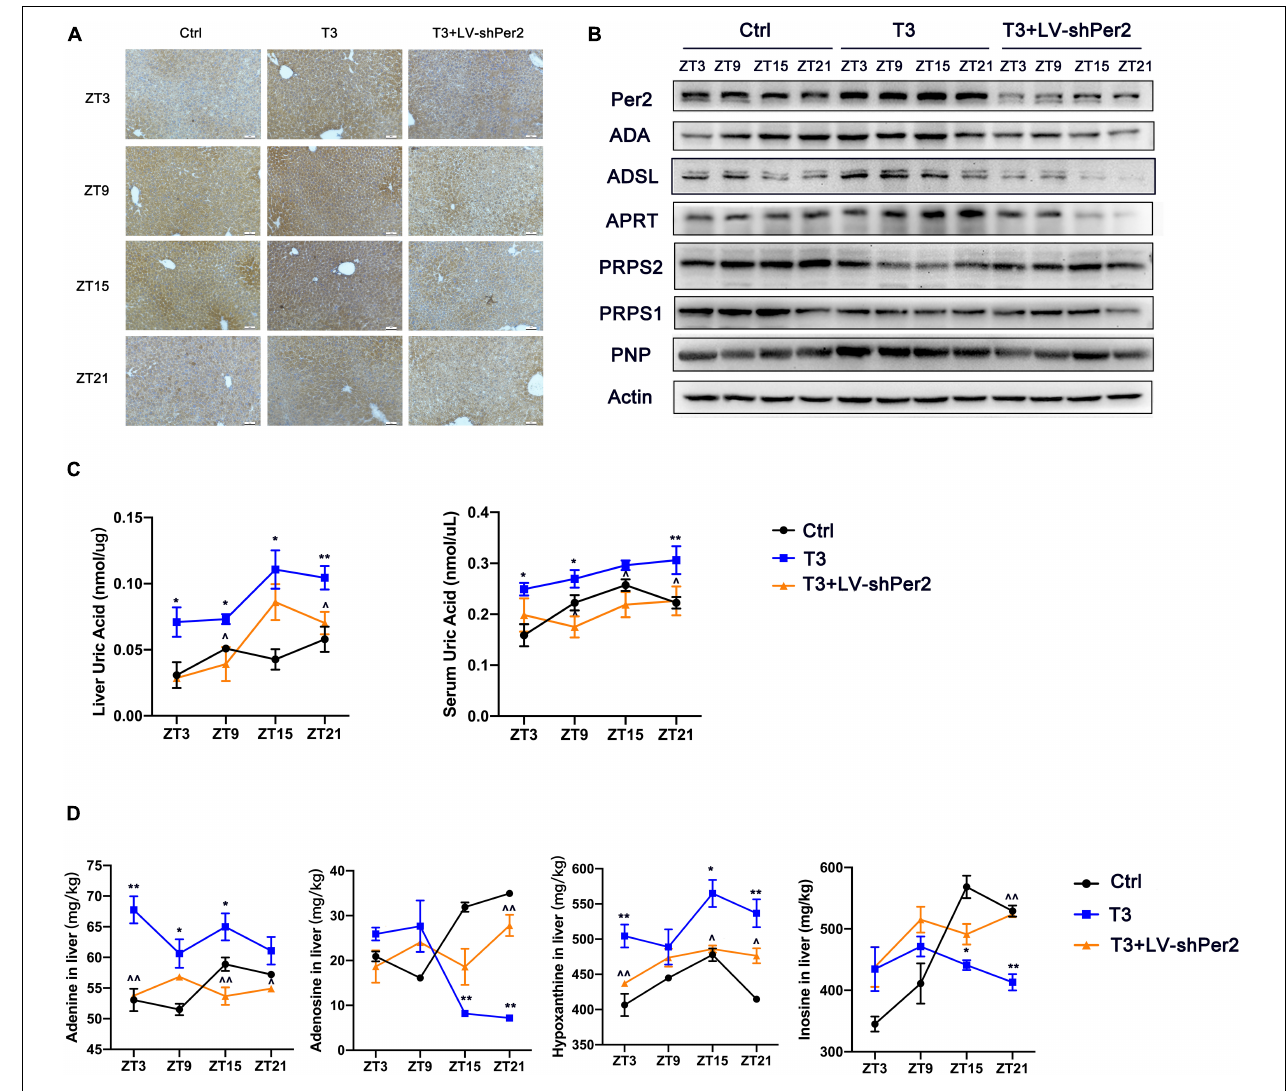
FIGURE 5 | (A) Immunohistochemical images of Per2 in mouse liver (200 × ). (B) Expression of nucleotide metabolism enzymes in mouse liver. (C) Urate levels in mouse liver and serum samples. (D) Levels of adenosine, adenine, hypoxanthine, and inosine in mouse liver (* P < 0.05 and ** P < 0.01, T3 group compared with control group; ˆ P < 0.05 and ˆˆ P < 0.01, T3 group compared with T3 + LV-shPer2